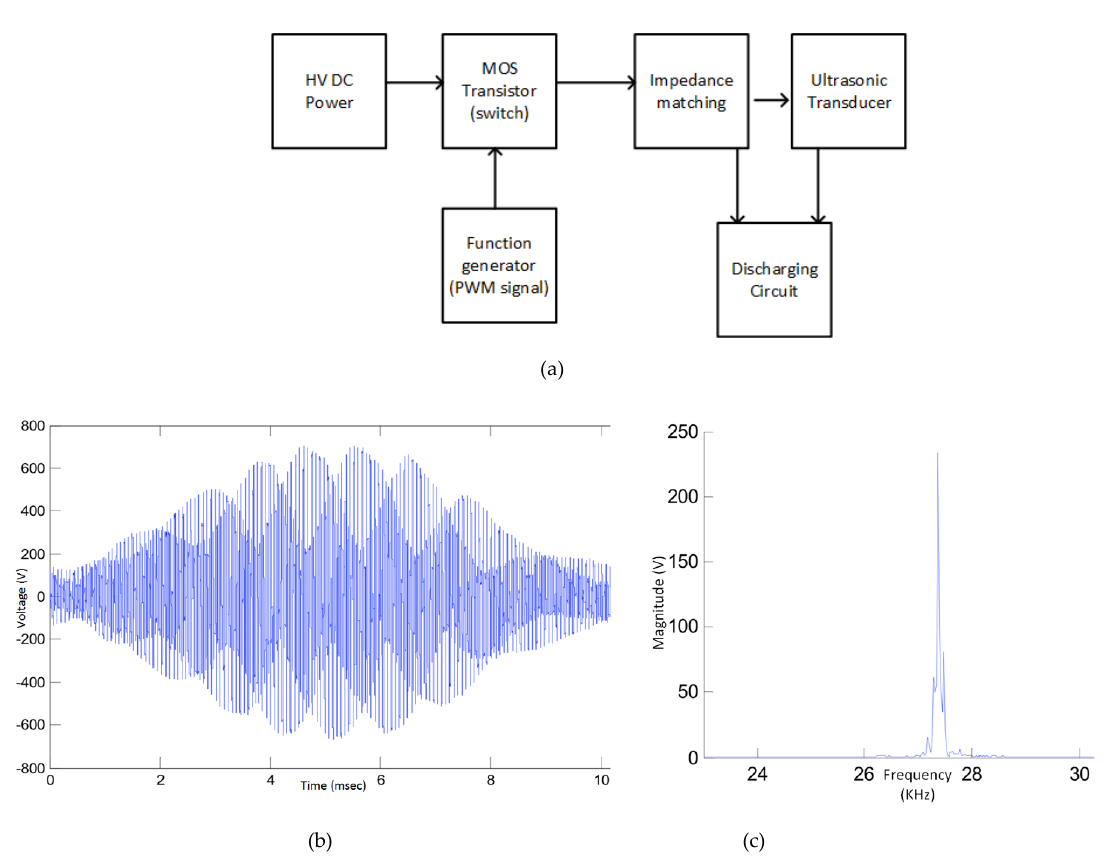
Figure 3. Schematic and characterization of utilized electronic circuit: (a) The block schematic of the designed circuit; (b) Measured voltage when transducer is actuated by 26.7 kHz; (c) The frequency domain representation of the voltage waveform given in (b).